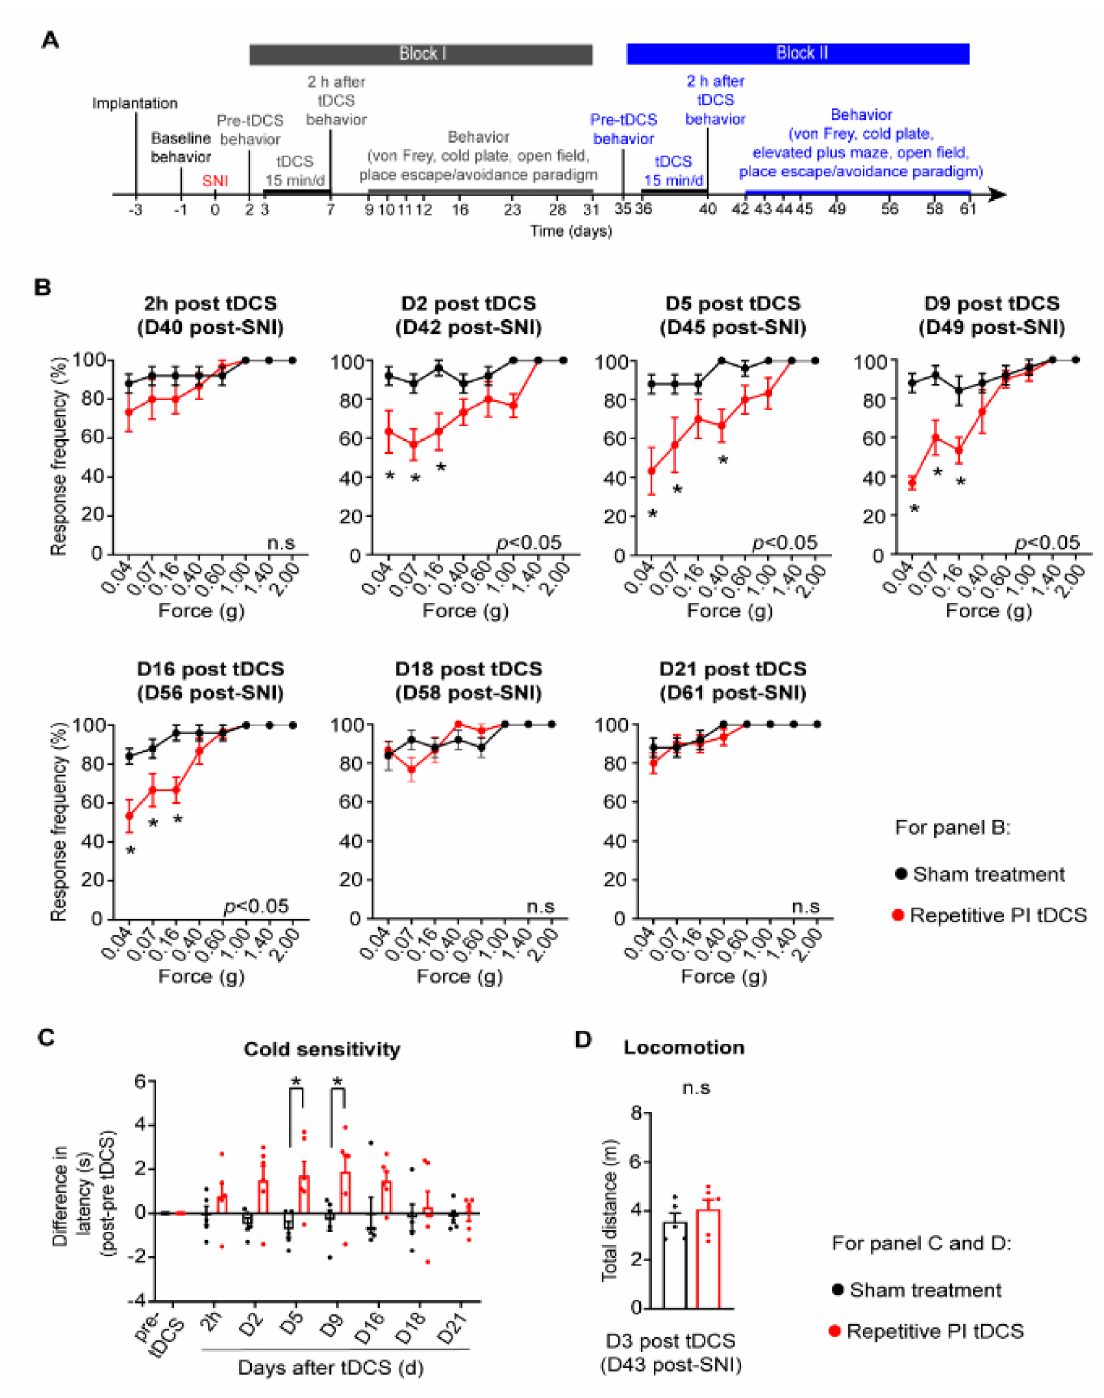
Figure 2. Reversal of established mechanical allodynia and cold allodynia over the late stages of neuropathic pain post-nerve injury by repetitive PI tDCS. ( A ) Schematic overview of experimental plan involving application of repetitive tDCS (Block II) several weeks after nerve injury. ( B ) Behavioral analysis of mechanical hypersensitivity to graded von Frey filaments over 40–61 days post-SNI. ( C ) Behavioral analysis of cold hypersensitivity to 5 ◦ C in the same groups of mice. ( D ) Effect of Block II PI tDCS on mobility in an open field; n = 5 mice for the sham treatment group, n = 6 mice for the repetitive PI tDCS group; repeated measures ANOVA with Sidak’s multiple comparisons test was performed; * p < 0.05 as compared to the sham treatment group. n.s. represents non-significant differences between two groups. Data are represented as mean ±